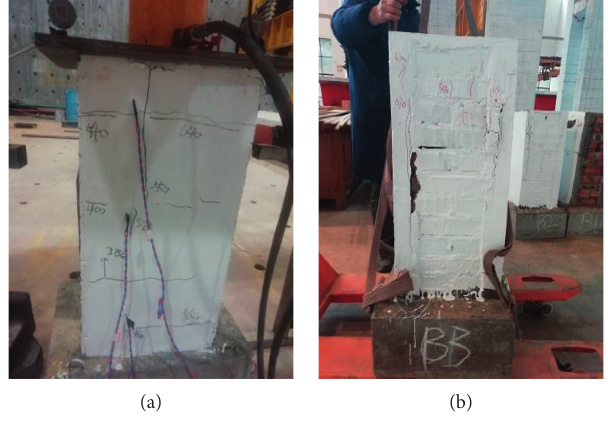
Figure 7: Typical failure of group ZB.